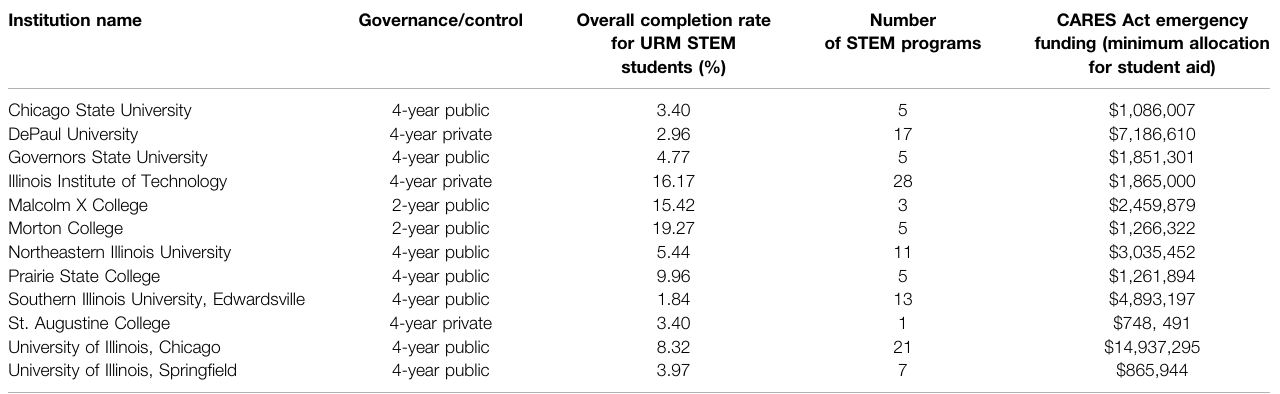
TABLE 1 | IL-LSAMP institution